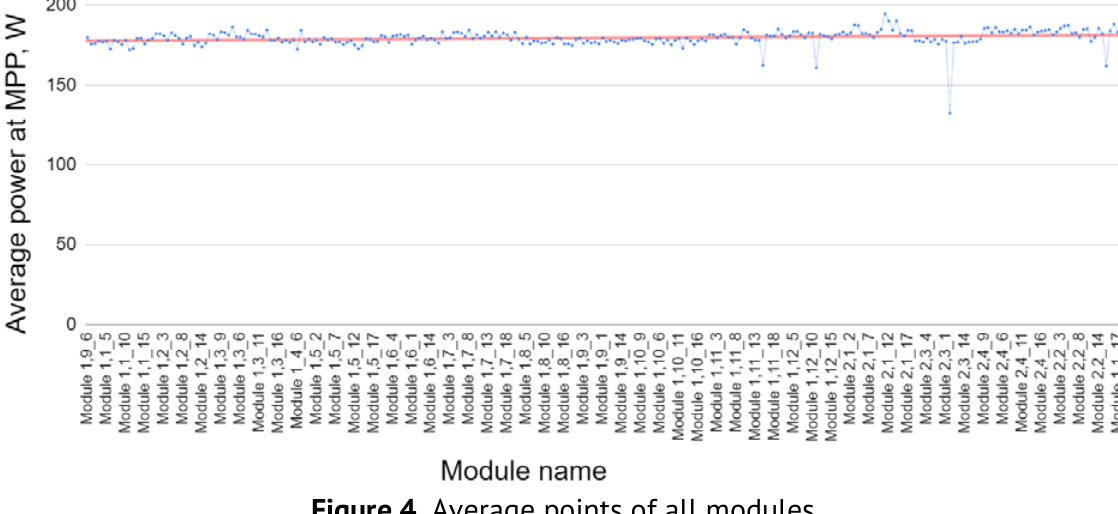
Figure 4. Average points of all